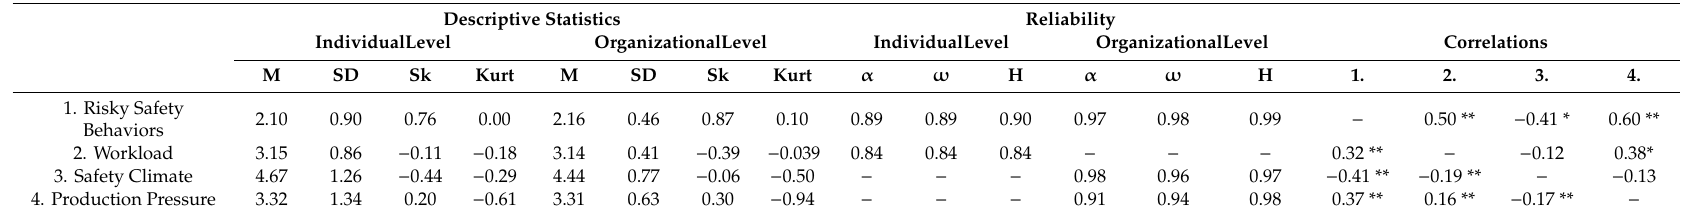
Table 1. Descriptive Statistics, Reliability Coe ffi cients and Zero-Order Correlations among the Study Variables.